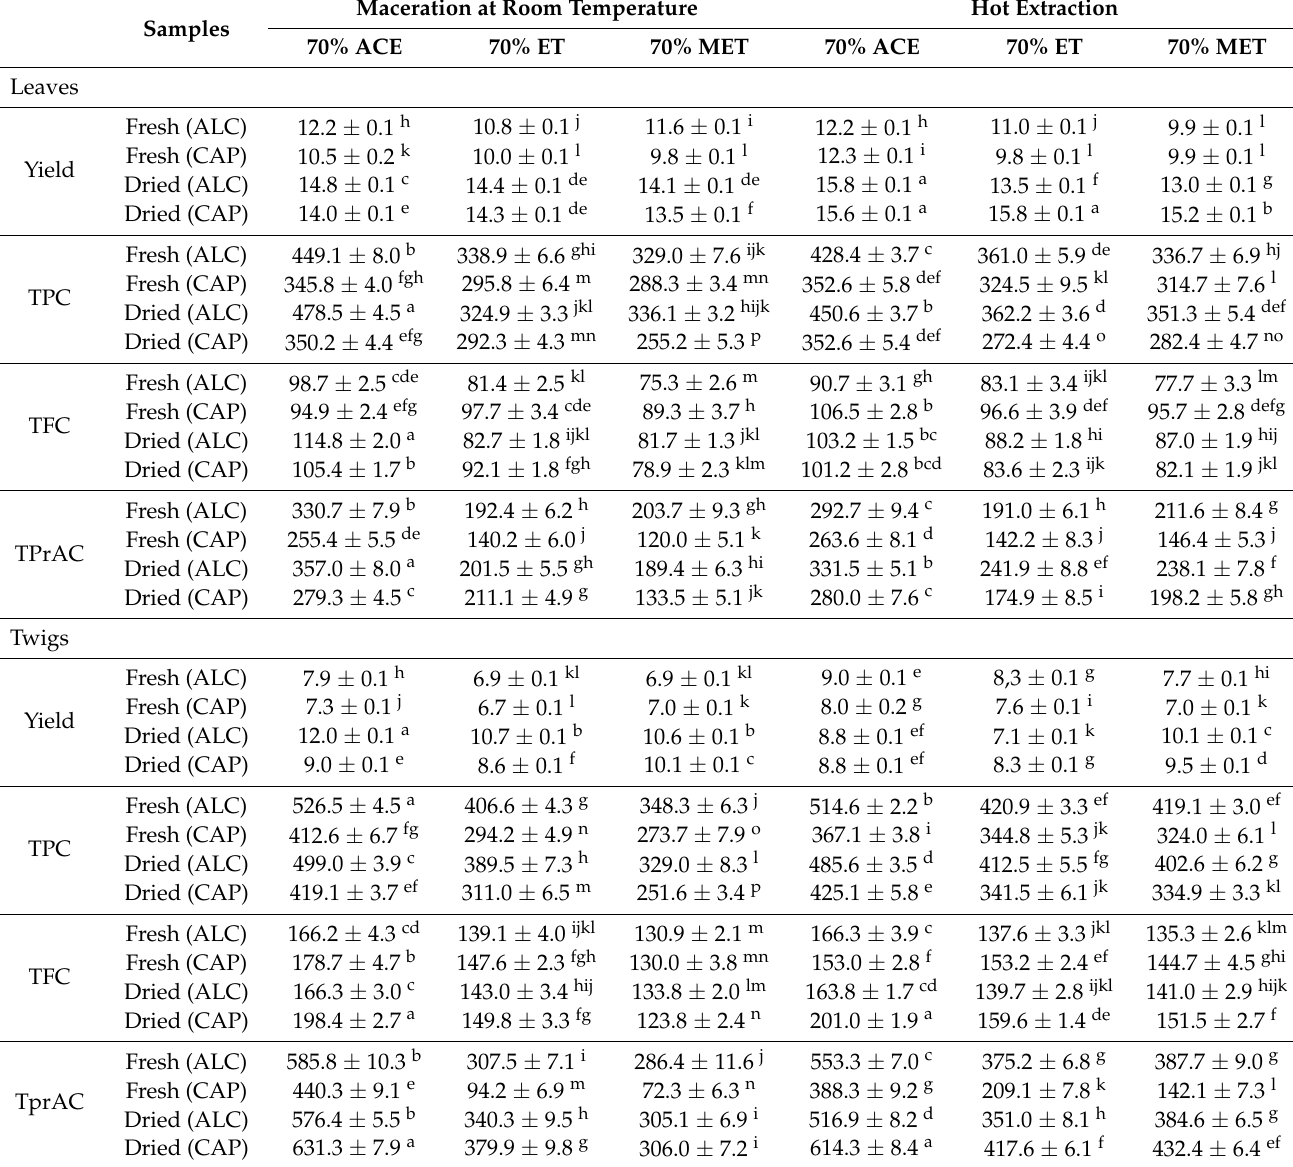
Table 1. Extraction yields (%, wet basis), TPC (mg GAE/g extract), TFC (mg CatE/g extract), and TPrAC (mg PycE/g extract) of extracts from fresh and dried leaves and twigs from Alcobaça (ALC) and Caparica (CAP), using different extraction solvents and extraction methods; TPC, TFC, and TPrAC expressed relative to the mass of biomass are presented in the Supplementary Material, Table